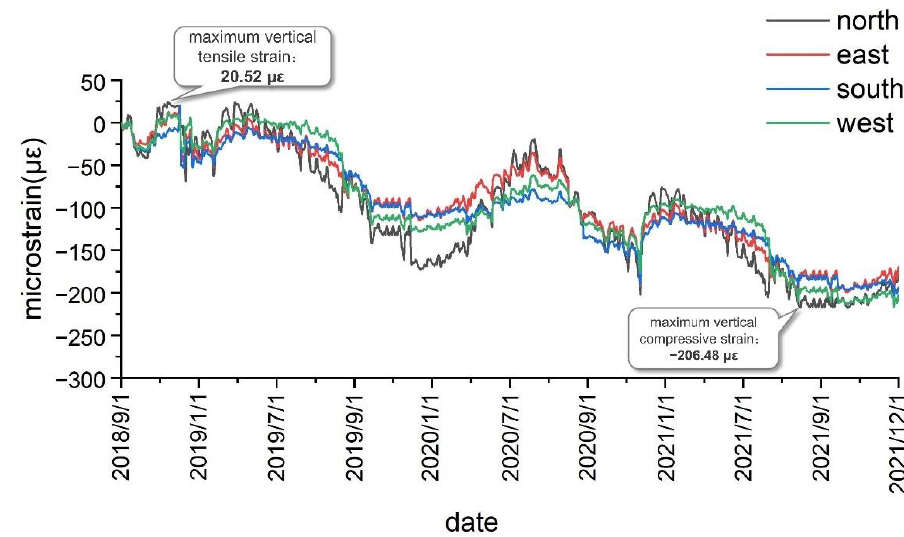
Figure 13. Measured vertical strain curves at second monitoring level.